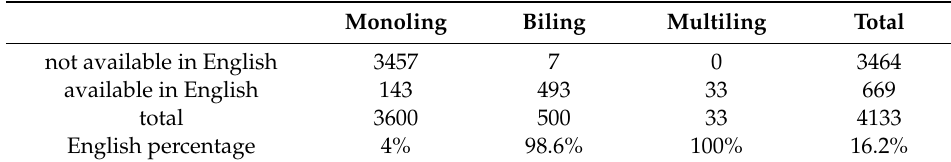
Table A40. English language availability (nl).